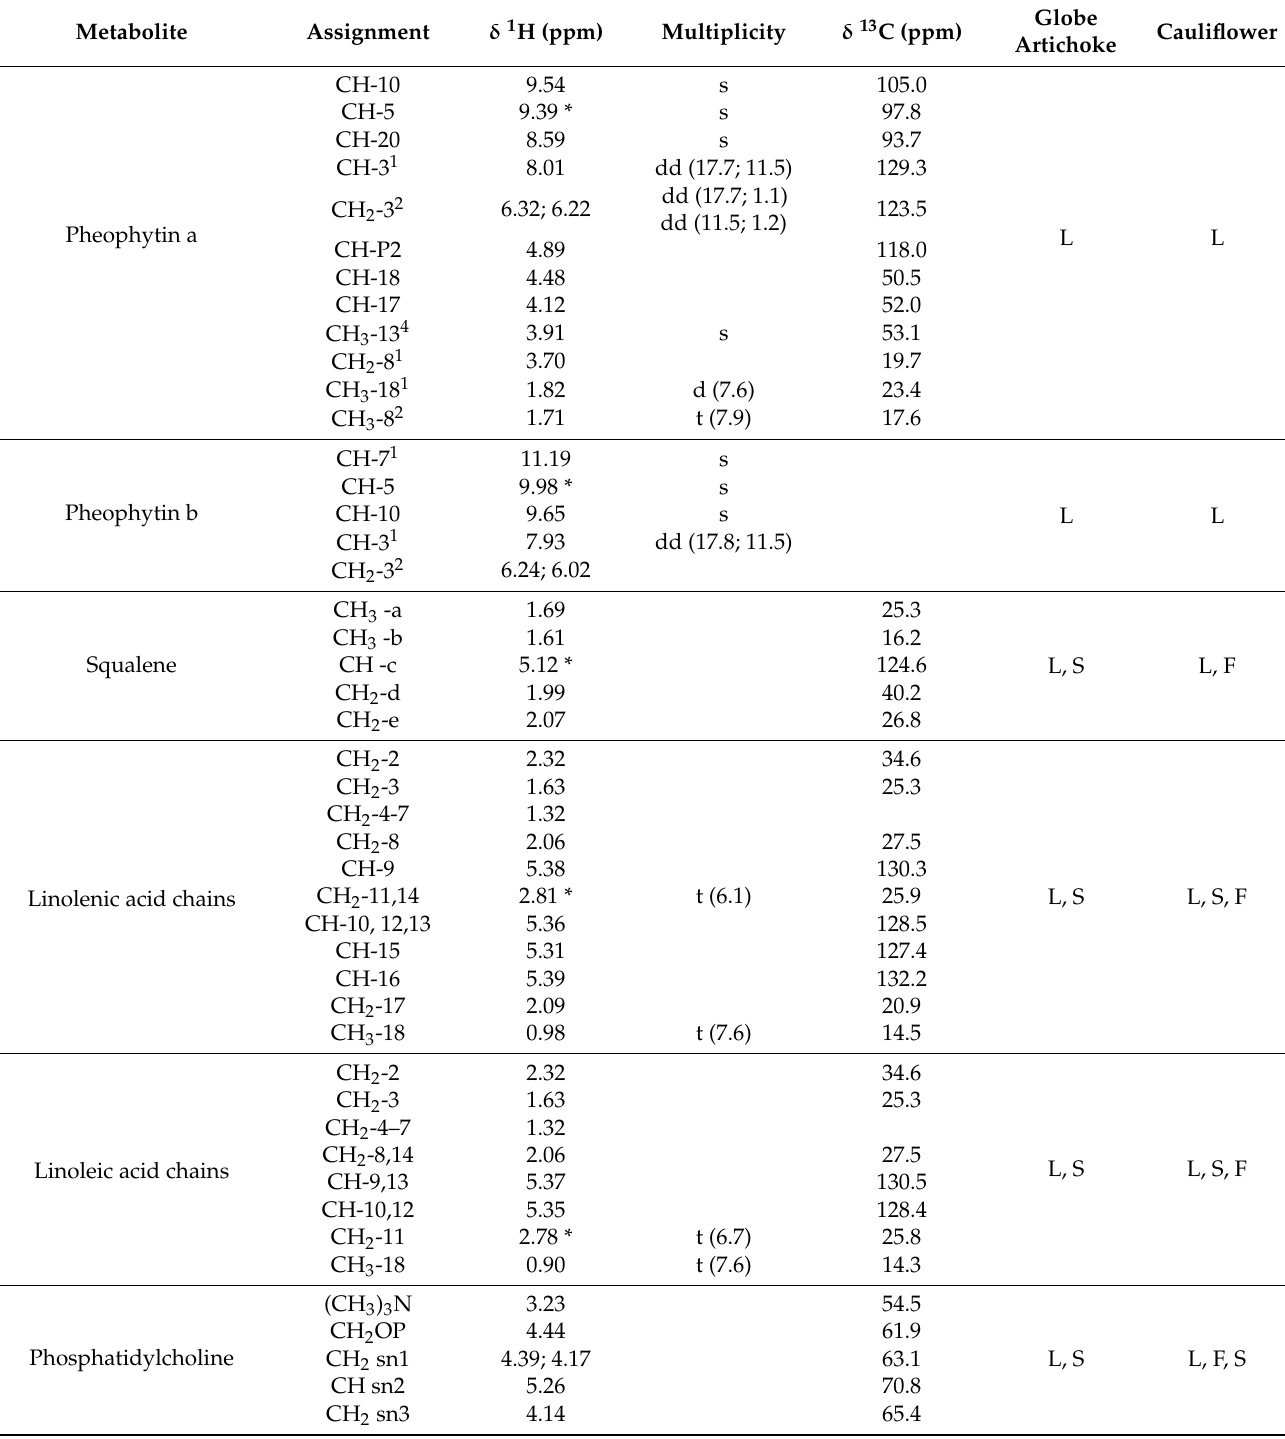
Table 3. Metabolites identified in chloroform extracts of cauliflower and globe artichoke byproducts. Relative assignments of 1 H and 13 C NMR signals are reported. L = leaves; S = stalks; F = florets; d = doublet; dd = doublet of doublets; s = singlet; t = triplet.